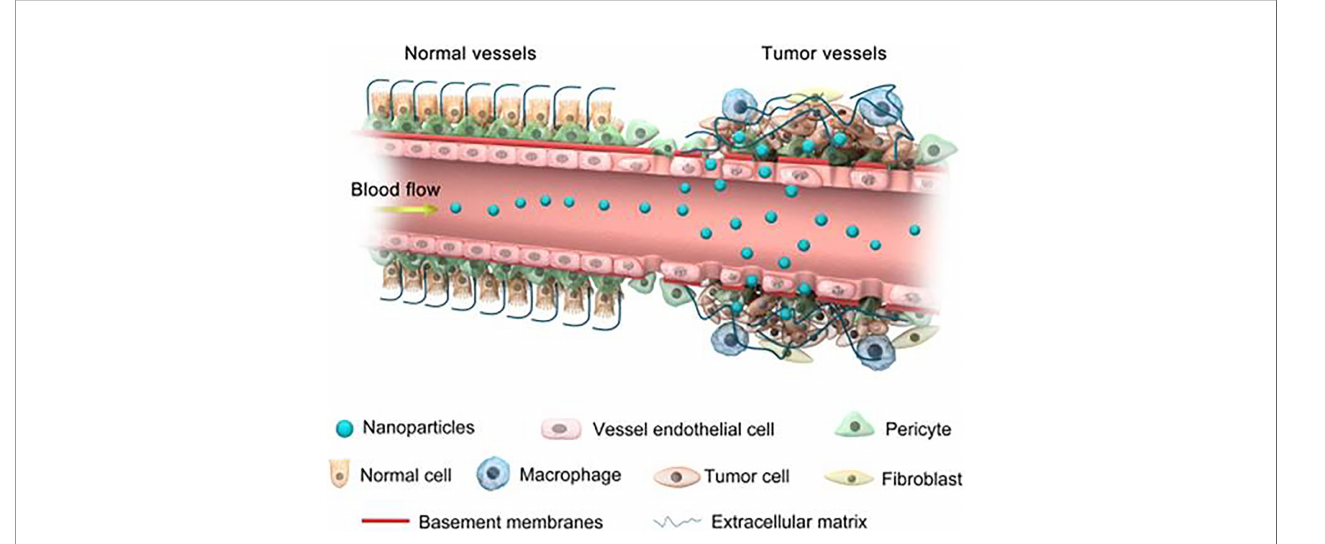
FIGURE 2 | Schematic diagram of nanoparticles targeting tumour tissues through enhanced permeability and retention (EPR) effect. Normal blood vessels are composed of dense endothelial cells, which can prevent the escape and extravasation of nanoparticles. Blood vessels of tumour tissue are leaky and highly permeable, allowing the preferential accumulation of nanoparticles in the interstitial space of the tumour. Reproduced with permission (42). Copyright 2018, Ivyspring International